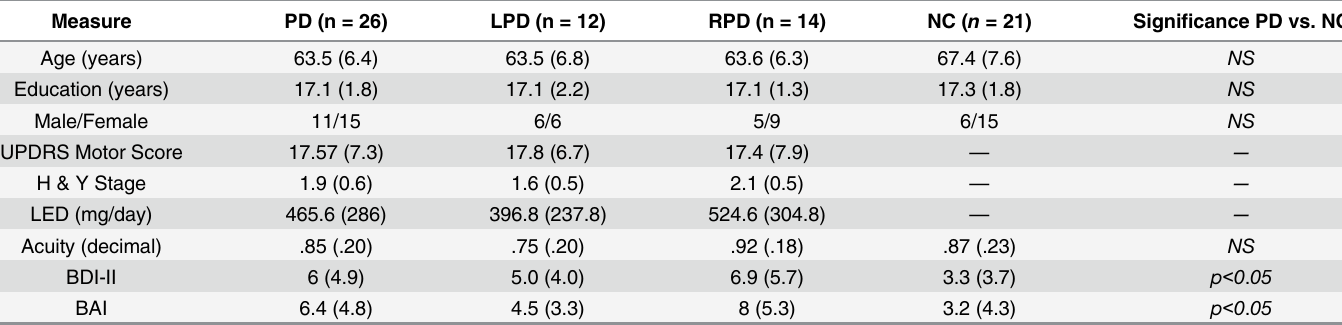
Table 1. Participant